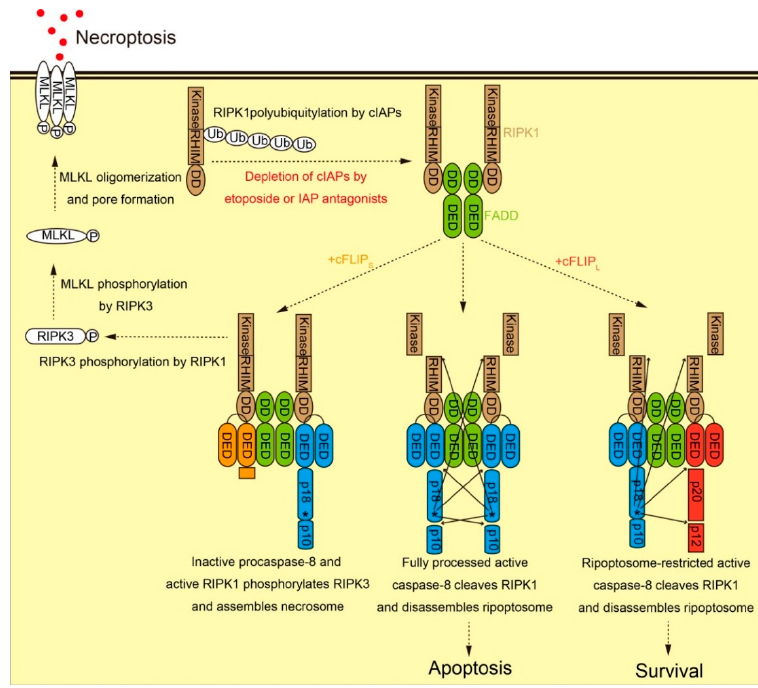
Figure 3. Functional role of cFLIP during ripoptosome formation. RIPK1 (brown) is composed of catalytic kinase domain, RIP homotypic interaction motif (RHIM), and DD. Upon RIPK1 activation by genotoxic stress, DD of RIPK1 is exposed and binds to DD of FADD (green). Subsequently, DED-containing proteins including procaspase-8 (blue), cFLIP L (red), and cFLIP S (orange)